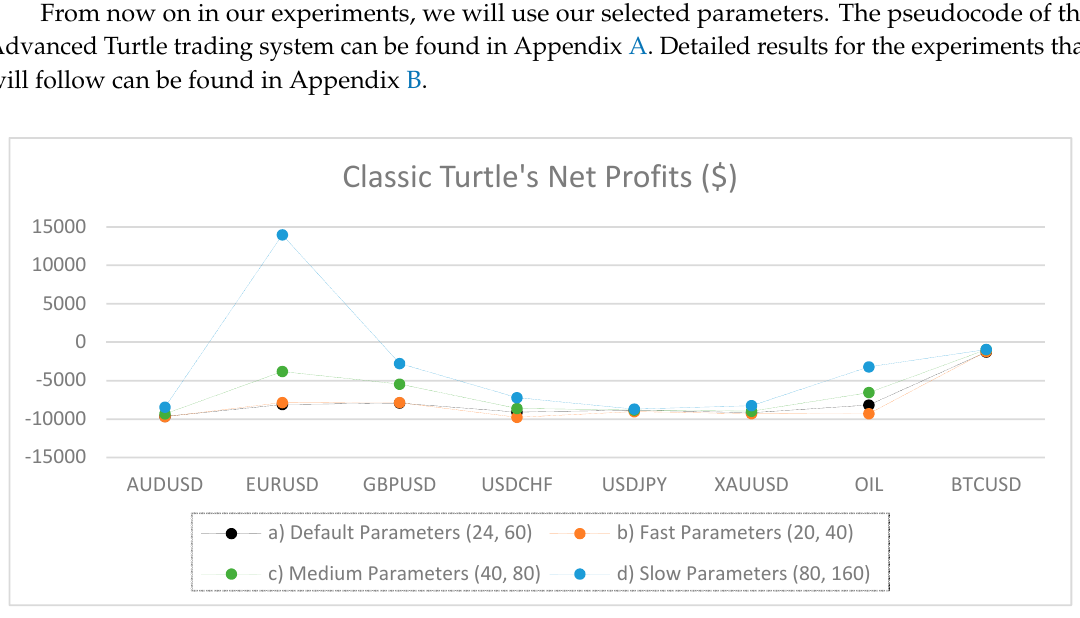
Figure 8. Drawdown as percentage of equity for experiments (a), (b), (c) and (d). 3.2. Sliding and Variable ATR Zone Next, we examined (e) the stop loss strategy of the sliding and variable ATR zone, where a stop loss barrier is formed at ±X*ATR(N) after a new position is opened. We tested every combination of parameters for N: {12, 24, 36, 48}, and X: {1, 2, 3, 4} for every set of the selected parameters and compared the results with the ones from (f) the stop loss strategy of the sliding and variable ATR zone as described in Section 2.2.4, where apart from the stop loss barrier, an exclusion barrier is formed at ±Y*ATR(N) after a position is closed due to a stop loss being triggered. Again, we tested every combination of parameters for N: {12, 24, 36, 48}, X: {1, 2, 3, 4} and Y: {1, 2, 3, 4} for every set of the selected parameters. Figures 9–14 show the averages of profits and the averages of drawdowns of the assets for every combination of N, X and Y for the fast, medium and slow parameters respectively. It can be observed that the advanced Turtle expert advisor performs better than the classic Turtle expert advisor. This is apparent in Figures 5 and 7 with the fast and medium parameters, but we can also clearly distinguish many peaks in Figure 9 with the slow parameters, where, with the addition of exclusion barriers, the Turtle expert advisor yields better results. Additionally, a trend is evident as profits tend to be higher for bigger values of X. Less drawdown also coincides with higher profits as it can be seen when contrasting Figures 5 and 6. Similar results can be observed by contrasting Figures 7 and 8 as well as Figures 9 and 10.